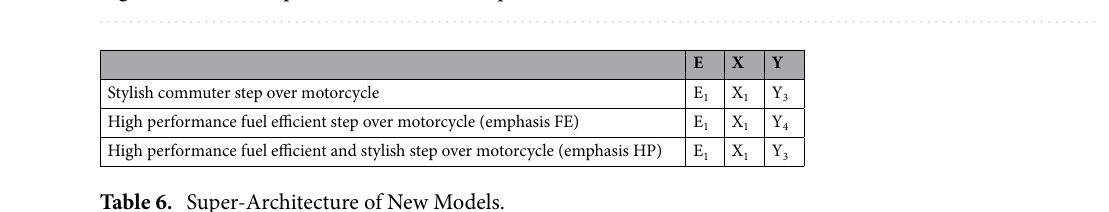
Figure 10. Product plan and differentiation plan.